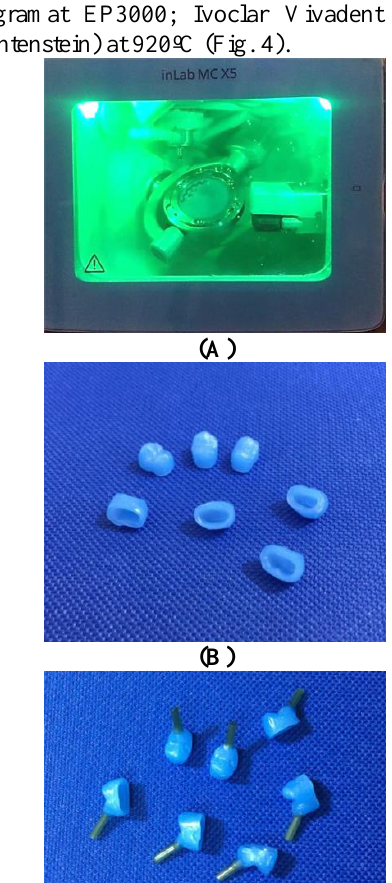
Figure 3: Impression taking with dental surveyor. Samples